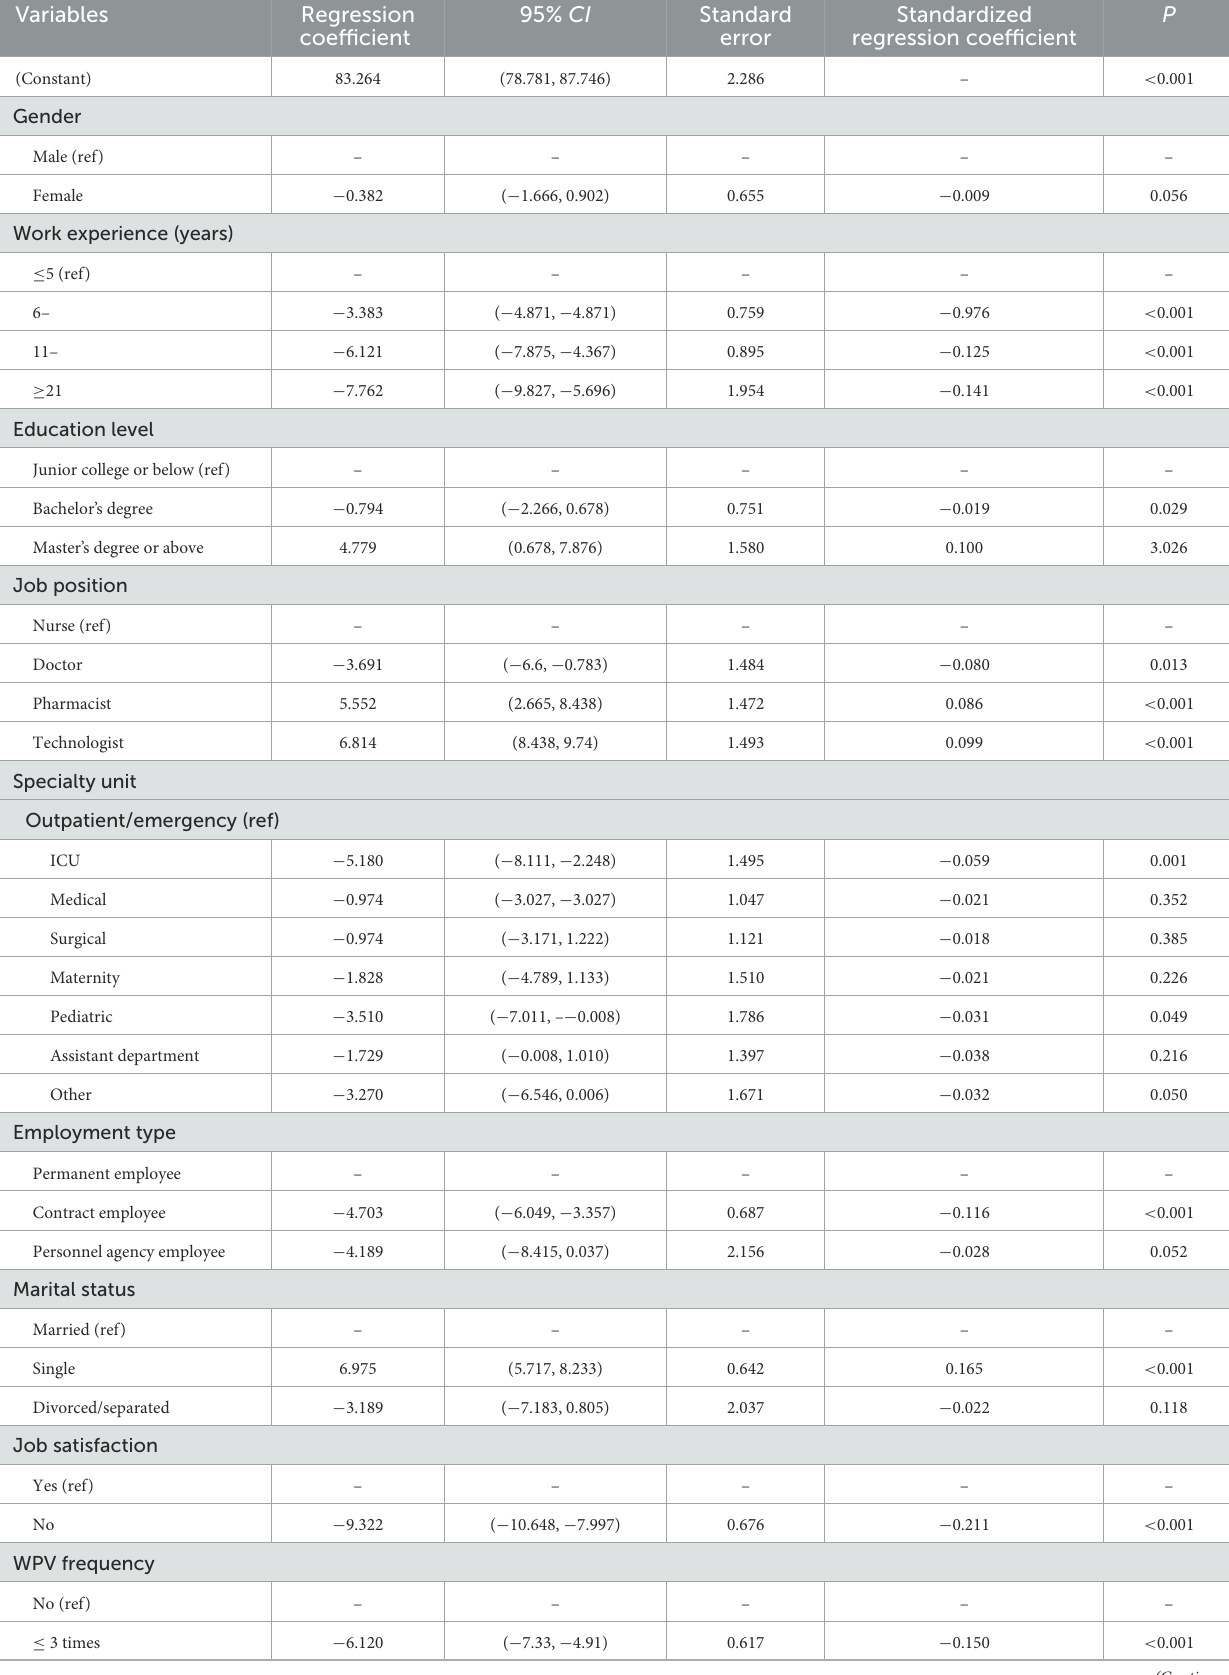
TABLE 3 Multiple linear regression analysis of influencing factors of healthcare workers security ( n =